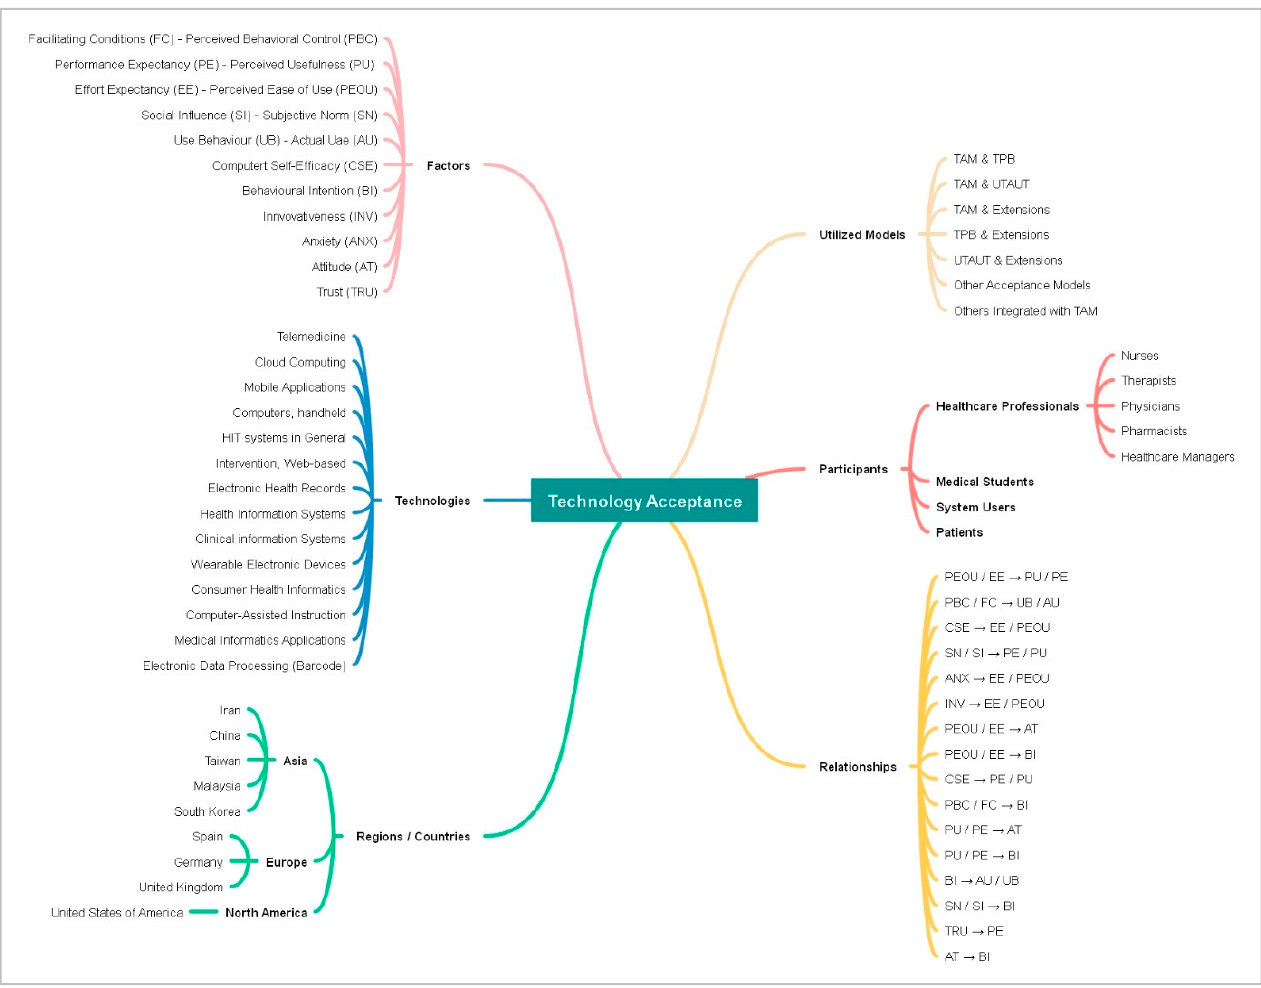
Figure 10. Mind map for the results summary.